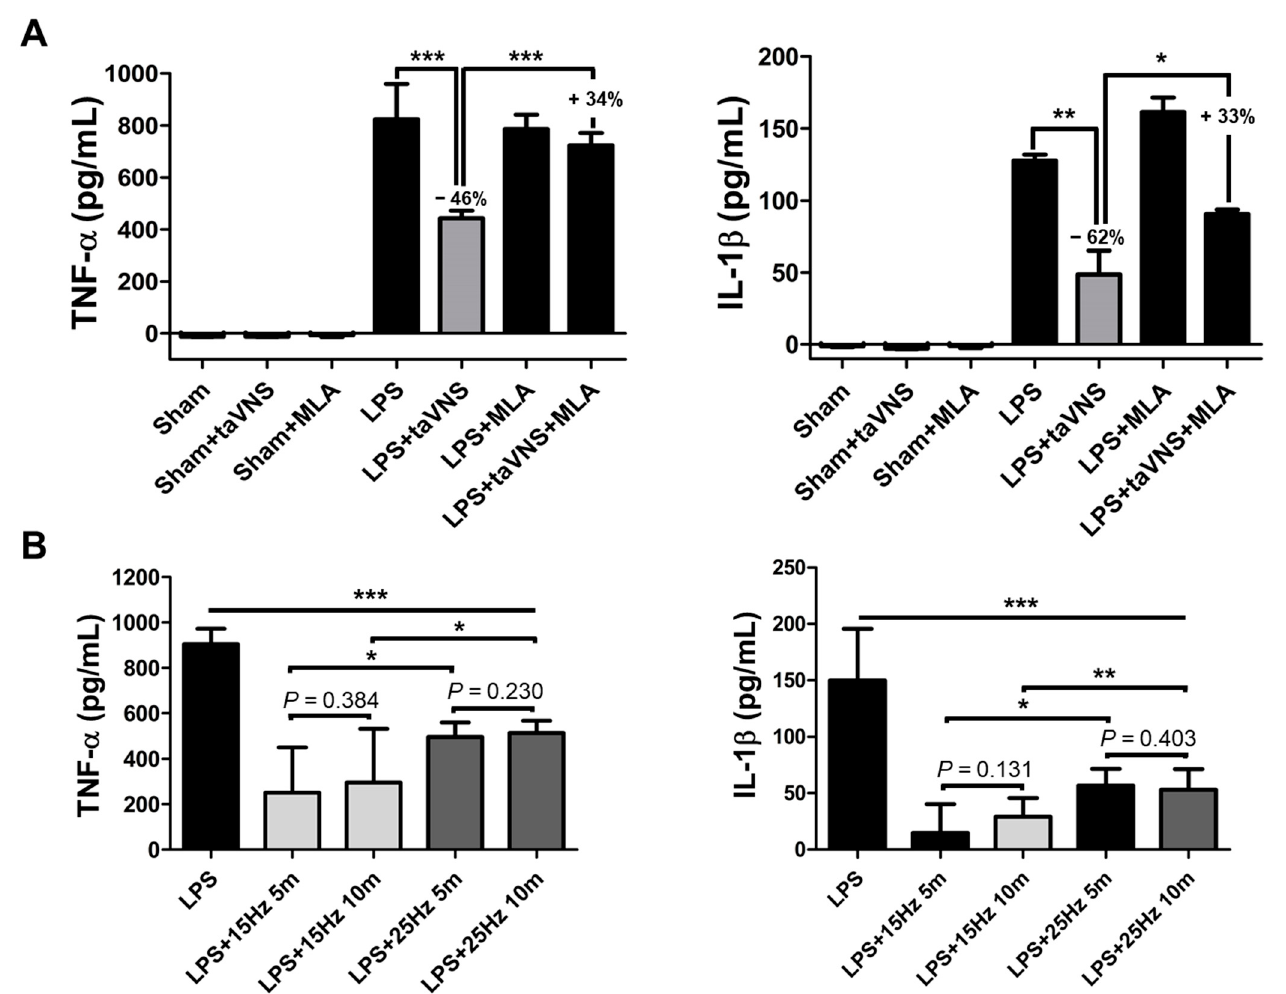
Figure 2. A decrease in pro-inflammatory cytokine releases by taVNS in LPS-induced endotoxemia. ( A ) Mice were treated with taVNS and/or MLA treatment for acute inflammation from LPS. The expression levels of serum TNF- α and IL-1 β were measured by ELISA. The decrease and recovery percentages of each cytokine were represented as a number. ( B ) The expression levels of serum TNF- α and IL-1 β were determined using ELISA pre- and post-treatment of taVNS with different pulse frequency and time parameters. Data have been presented as the means and SD; * p < 0.05, ** p < 0.01, and *** p < 0.001, compared to the corresponding control.